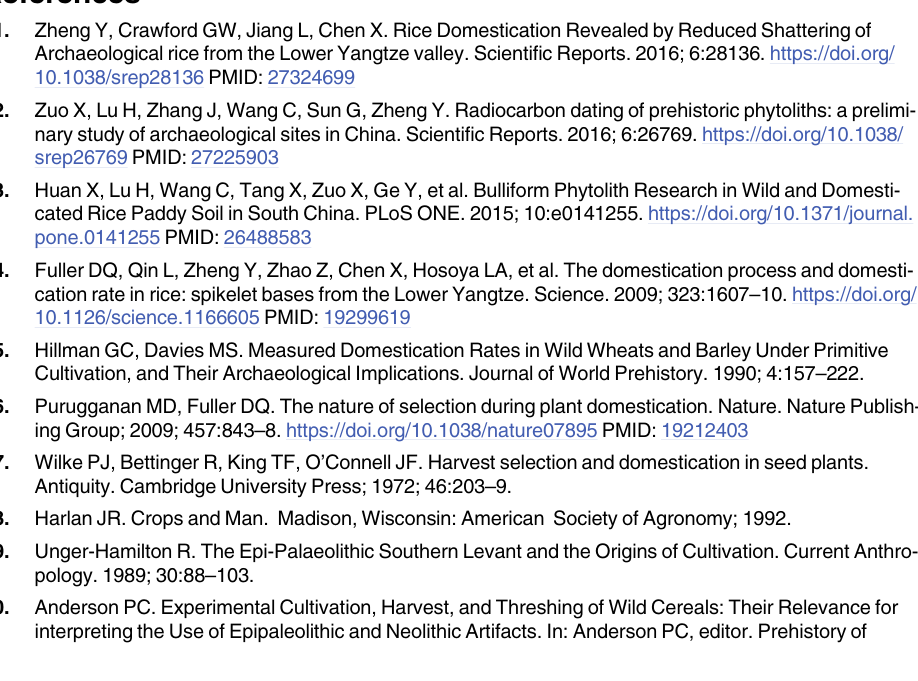
S2 Table. Phytolith residue